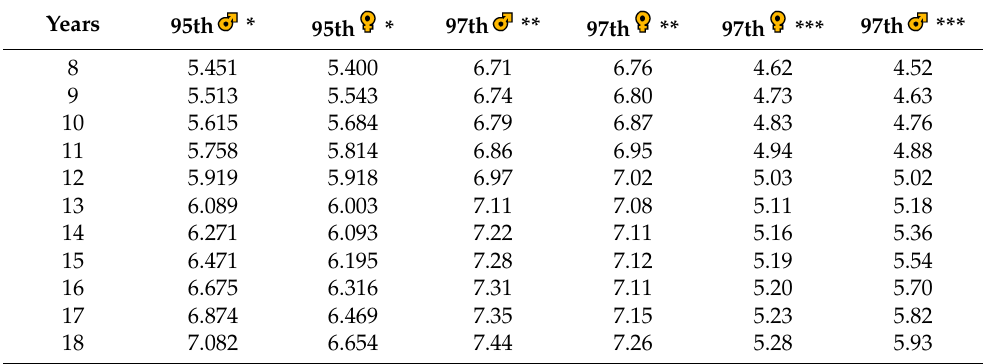
Table 2. Synopsis of recently published normative data for aortic PWV according to age for Males (